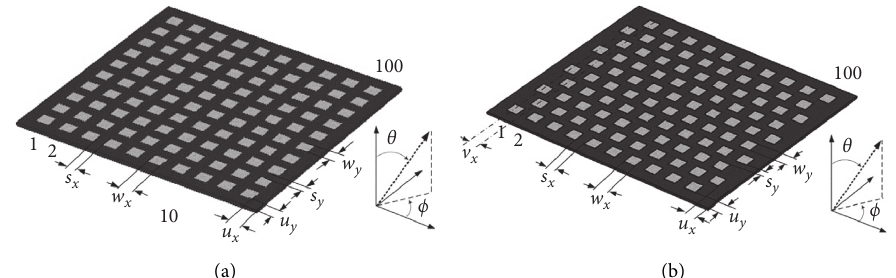
Figure 8: Planar array apertures comprising 100 linearly polarized microstrip patch antennas: (a) Cartesian grid; (b) triangular grid. Phase- only syntheses for reduced SLLs were performed using EM-simulated models in Ref. [54].